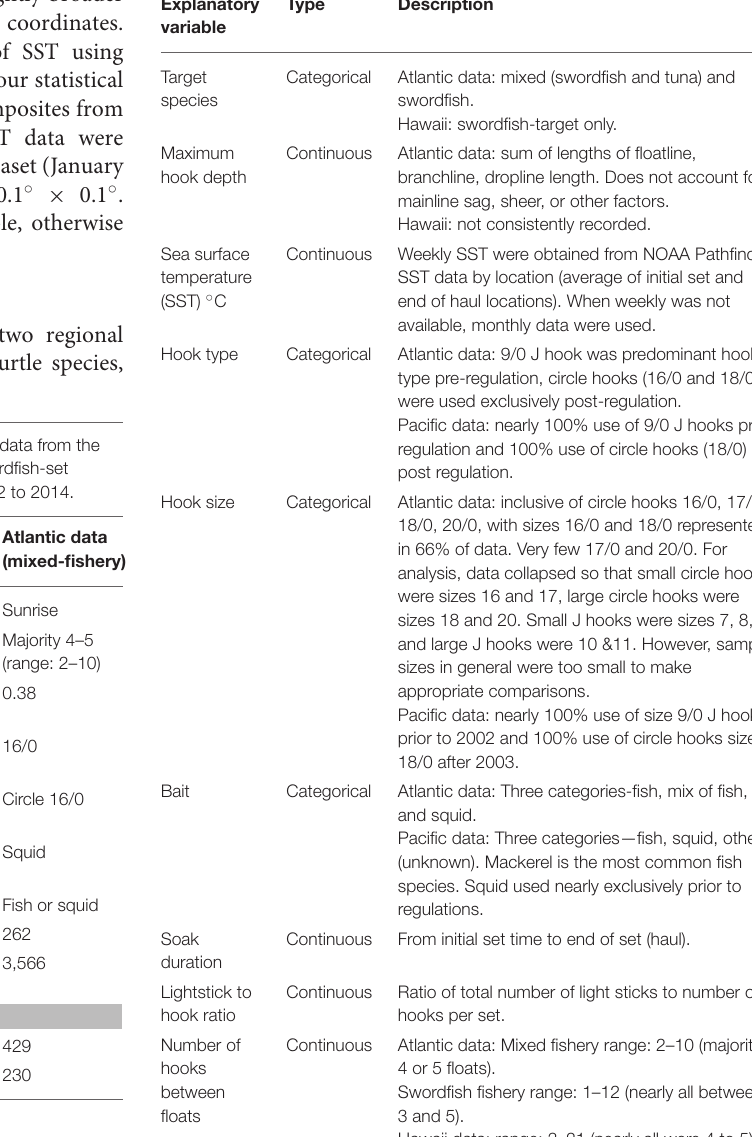
TABLE 2 | List of explanatory variables for Atlantic and Pacific observer data used in generalized additive mixed models. Explanatory